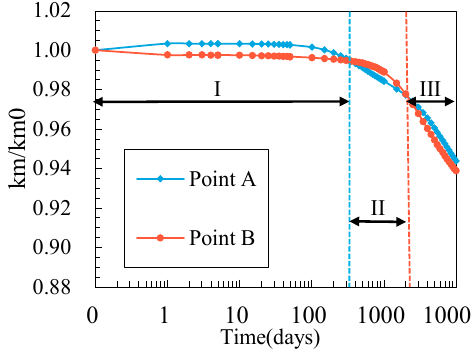
Figure 7. Evolution of matrix permeability at Point A and Point B. Point A is close to the injection well (IW) and Point B is close to the production well (PW).